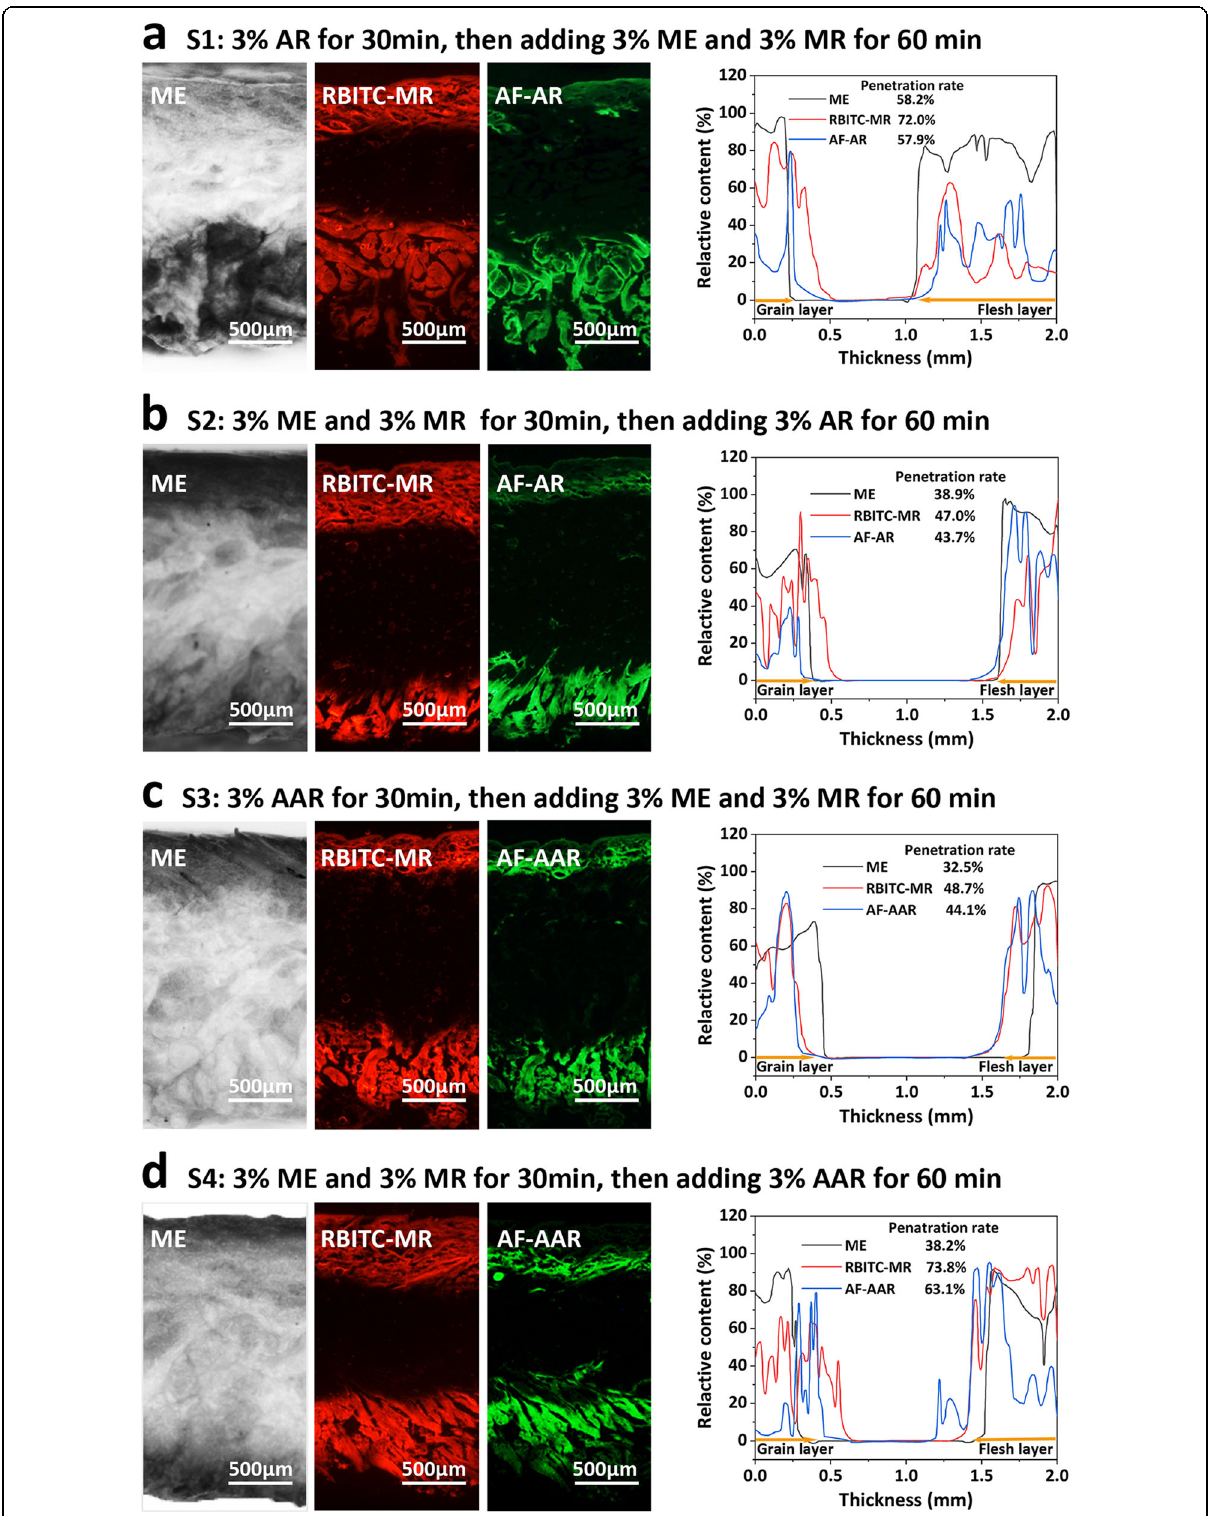
Fig. 6 Stereo micrograph and fluorescence micrographs of cross-sections of wet white retanned with multiple retanning agents, and relative contents and penetration rates of the retanning agents ( a : group S1; b : group S2; c : group S3; d : group